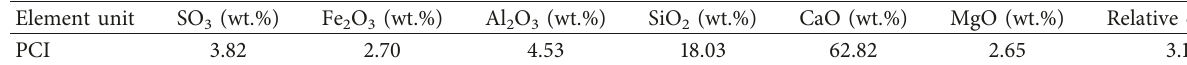
Table 2: Main chemical compositions of the cement used.